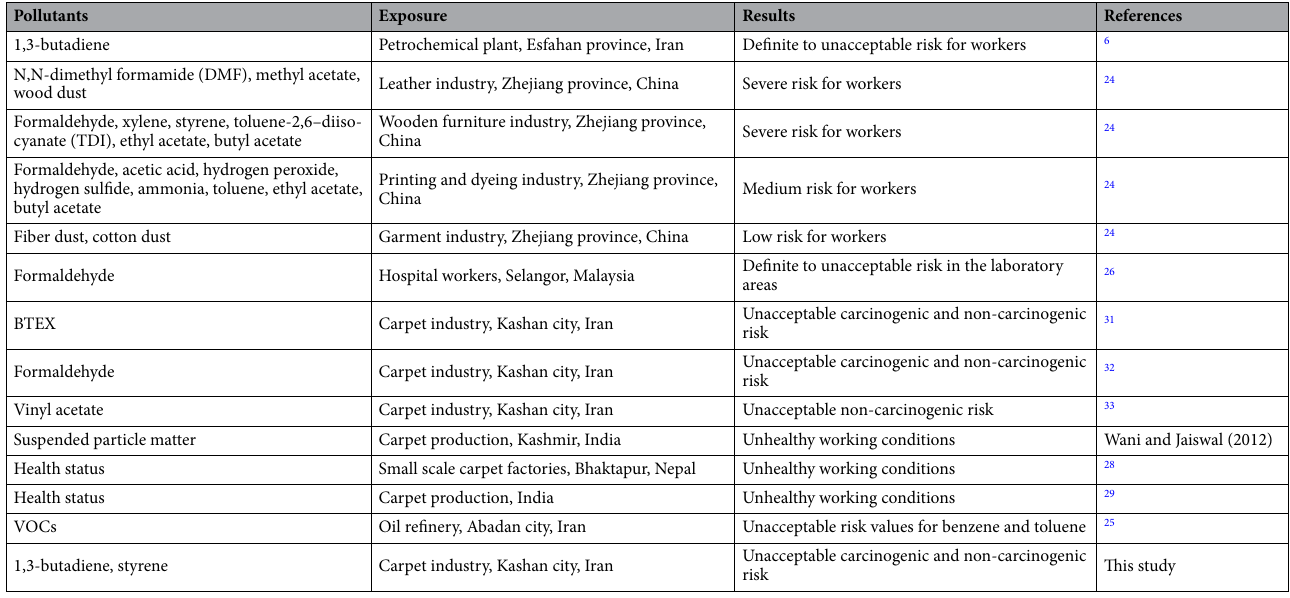
Table 1. Health risk assessment research on occupational exposure related with the